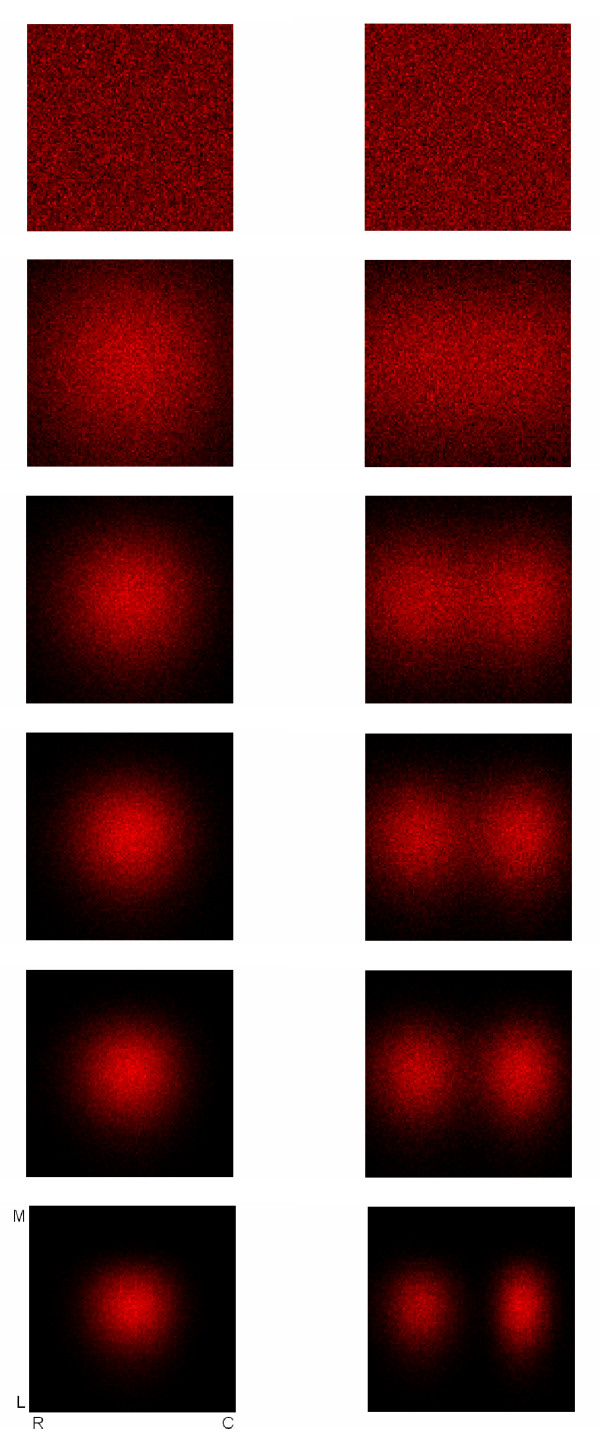
Map refinement. Wild-type (left) and ki/ki (right) map development for axons in the central retina. The retinal injection site is the same as in Figure 7, top row and central column. The temporal evolution of the map is shown for t = (0, 8, 16, 24, 32, and 100) × 10000 iterations. The orientation of images is the same as in Figure 7. The color map is rescaled in each image for visibility.